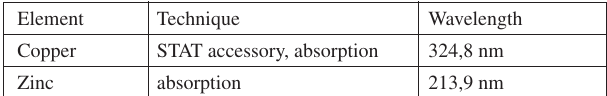
Table 1. Measurement conditions